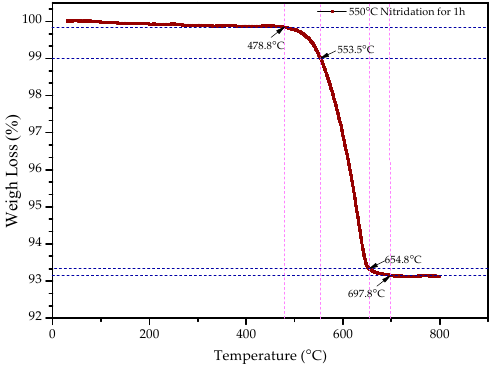
Figure 6. TG curve of ε -Fe(Si) 3 N.